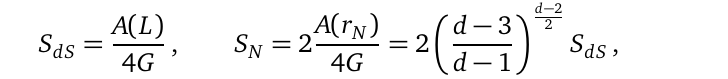
Figure 7: The difference between the linear fit S in units of S vs. the mass M in units of M dS (red), d = 5 (orange), d = 6 (green), d = 7 (cyan), d = 8